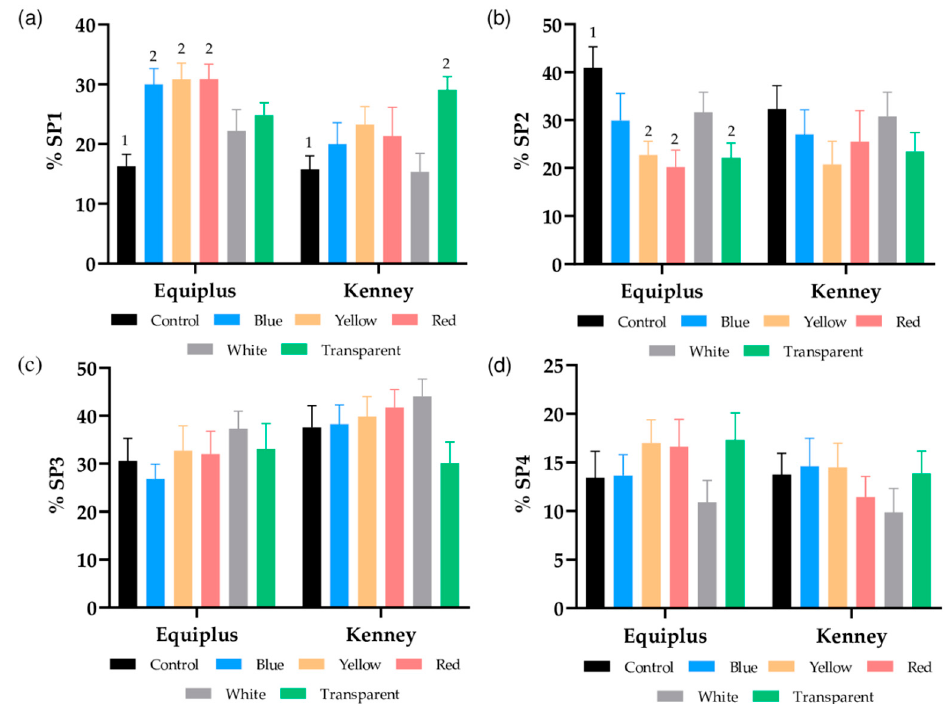
Figure 1. Effects of the color of the straw, extender, and light stimulation on the structure of motile sperm subpopulations in control (nonirradiated) and irradiated samples packed into straws of different color and extended either with Equiplus or Kenney extender. ( a ) Subpopulation 1 (SP1, which was the fastest subpopulation for VCL, VSL and VAP); ( b ) Subpop- ulation 2 (SP2, the slowest); ( c ) Subpopulation 3 (SP3); ( d ) Subpopulation 4 (SP4). The different numbers (1, 2) indicate significant differences ( p < 0.05) between irradiated and nonirradiated samples packed into different colored straws within the same diluent. The absence of numbers indicates the lack of statistical differences between irradiated and nonirradiated samples packed into different colored straws within the same diluent. On the other hand, no significant differences between nonirradiated and irradiated samples were observed when the two extenders were compared within the same treatment. Data are shown as mean ± SEM of 13 separate experiments.